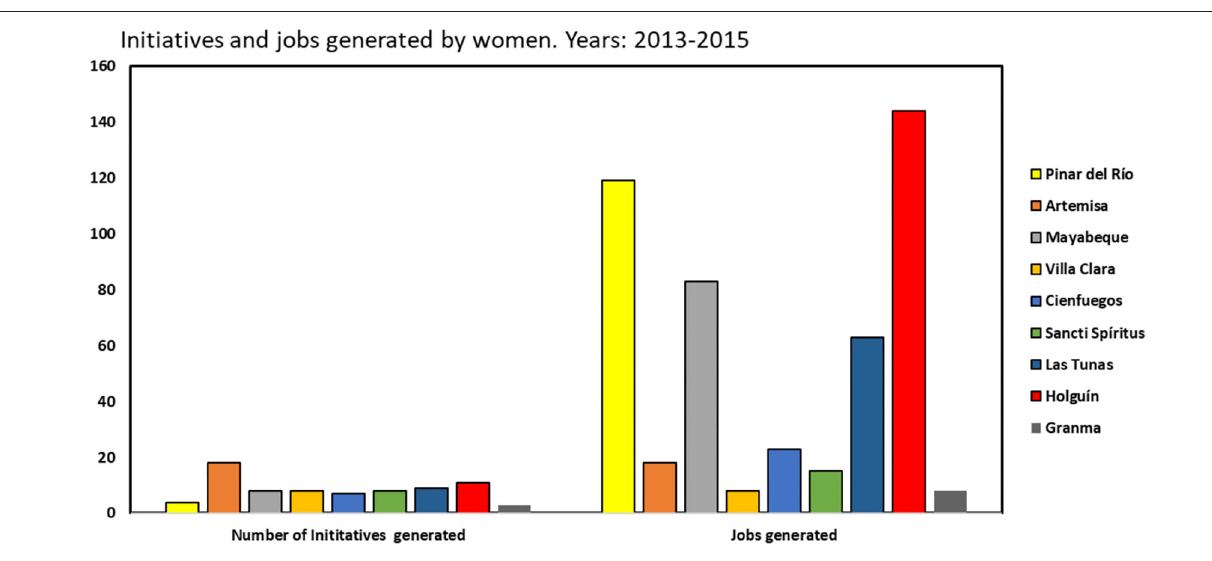
FIGURE 2 | Economic initiatives and jobs generated by women PIAL participants,